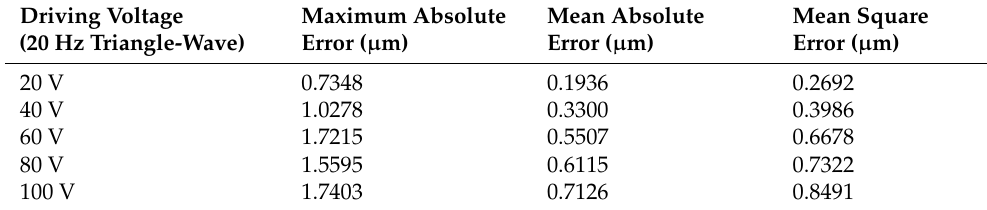
Table 4. SMPI model accuracies on variable voltage amplitudes.